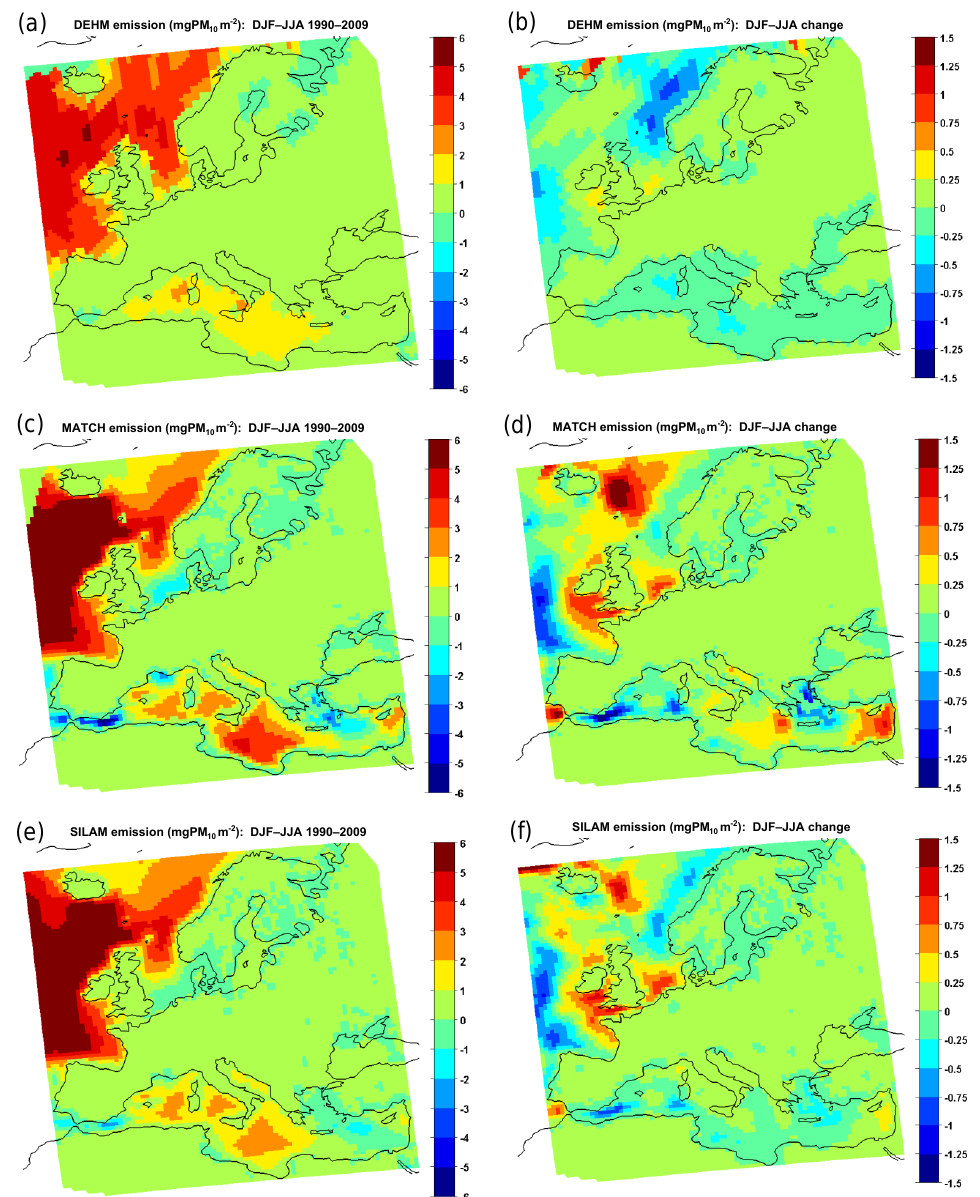
Figure 4. Sea salt emission (mgPM 10 m − 2 ) difference between winter (December, January, and February: DJF) and summer (June, July, and August: JJA) for DEHM, MATCH, and SILAM models. Left panels: past period (1990–2009); right panels: absolute difference between the future (2040–2059) and past